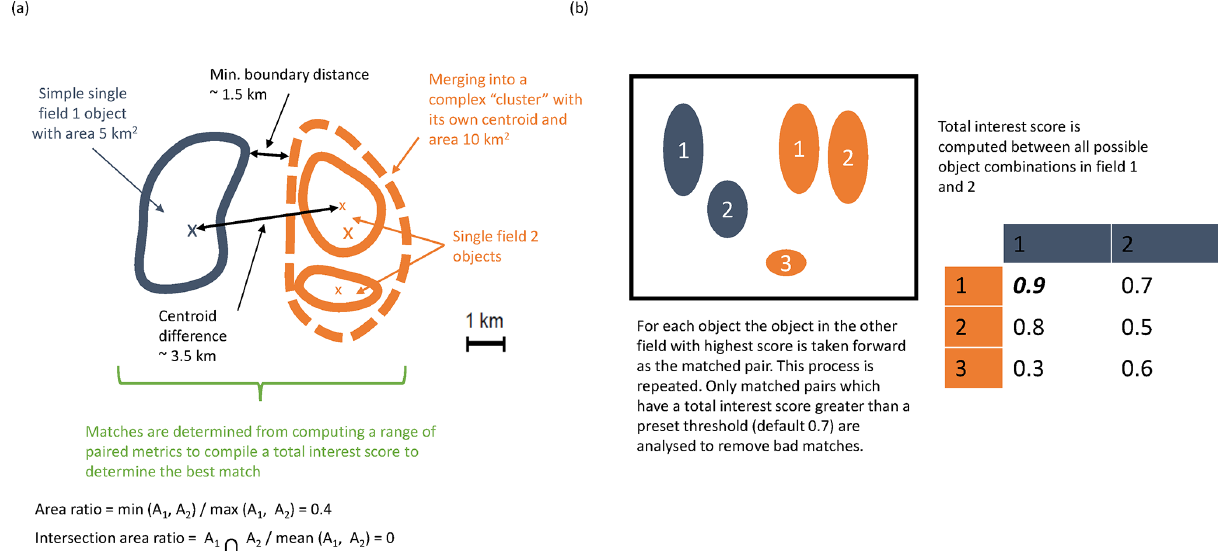
Figure 2. Schematic illustrating some of the key components of identifying objects using MODE. (a) Defining some of the terminology and key components for computing matched pairs. (b) Example of how the best matched pair is